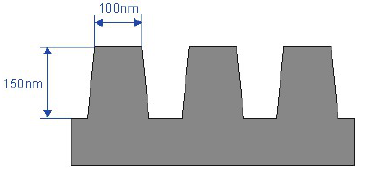
Figure 2. Cross section of Eulitha subwavelength grating ( p = 200nm) in Silicon with positive flank angles of 6 ◦ .